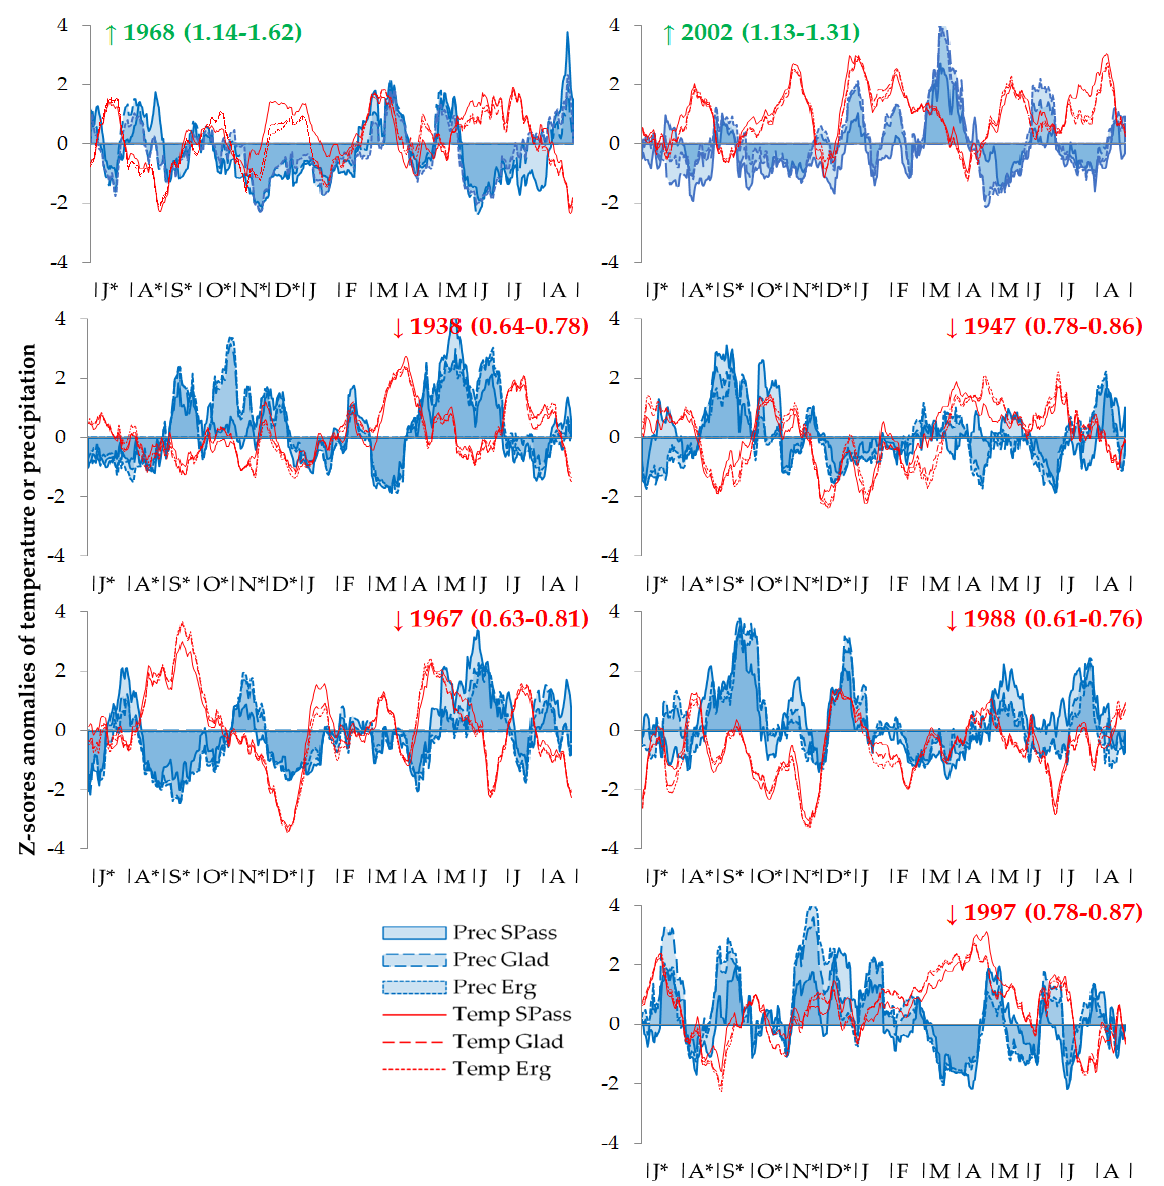
Figure 4. Weather during pointer years for P. sibirica : relative deviations of a 21-day window with 1-day step temperature (Temp, red lines) and precipitation (Prec, blue areas) series from average values over the 1936–2010 period calculated from the Z-scores ( mean = 0, SD = 1) over a period from previous July to current August for years when TRW > mean + SD (positive pointer years, marked with up arrow ‘ ↑ ’) or TRW < mean — SD (negative pointer years, marked with down arrow ‘ ↓ ’) in res chronologies from all six sampling sites. Numbers in brackets after each year are ranges of the res TRW indexes.